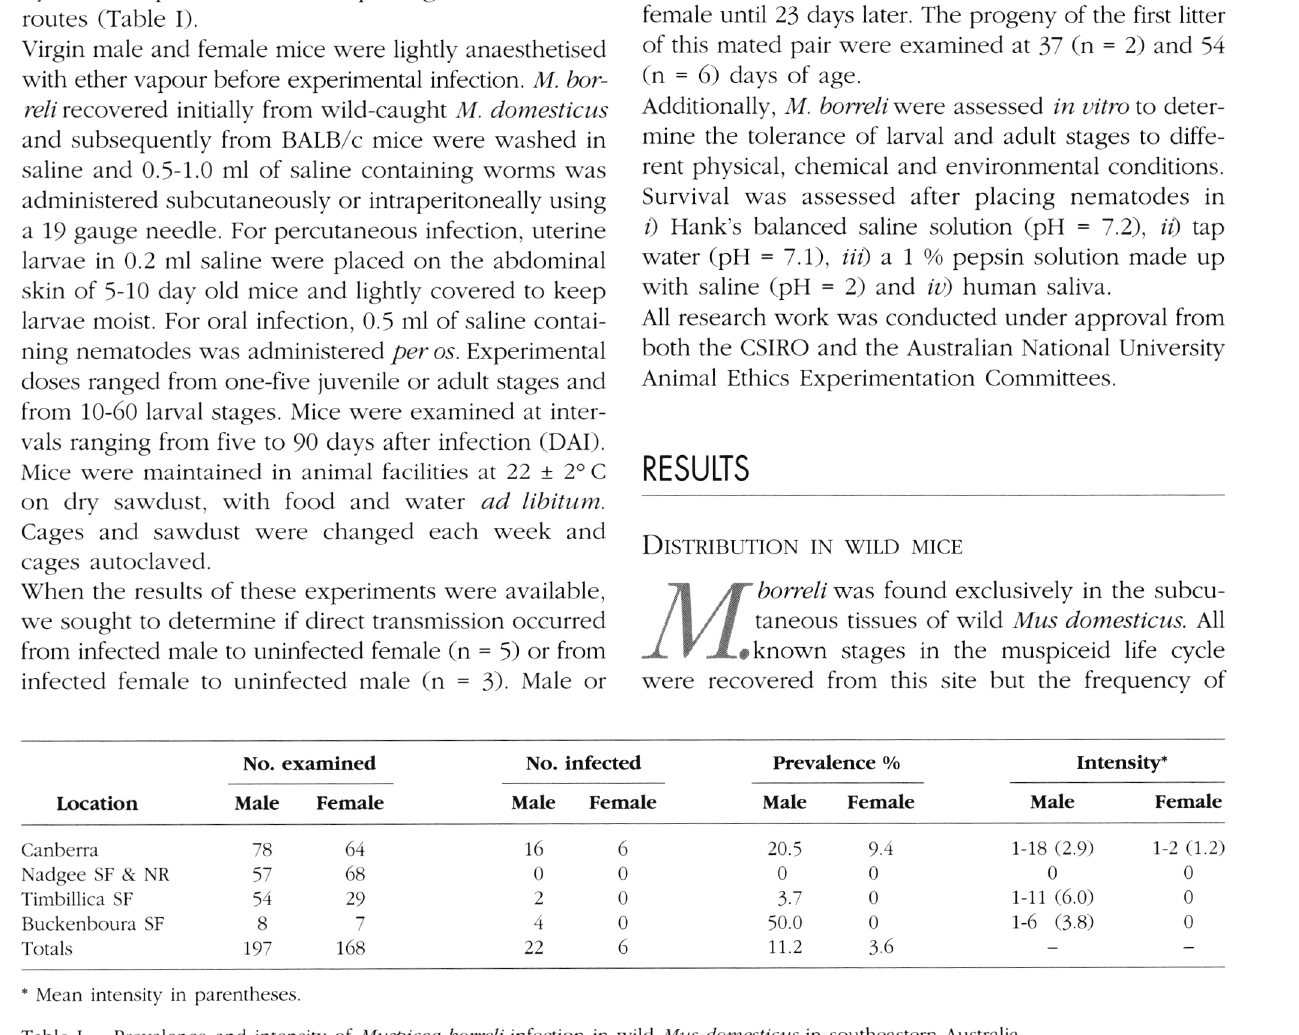
Table I. - Prevalence and intensity of Muspicea borreli infection in wild Mus domesticus in southeastern Australia. Parasite, 2002, 9,